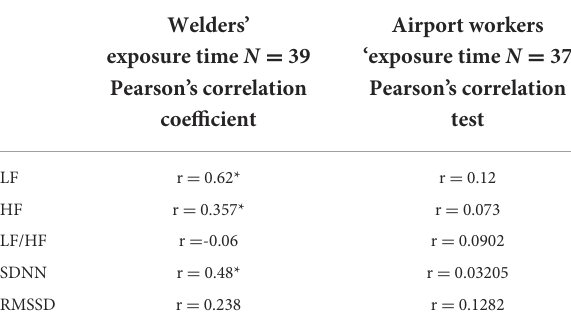
TABLE 7 Correlation between HRV value per hour and peak noise measurements per hour by group of workers with Pearson’s correlation